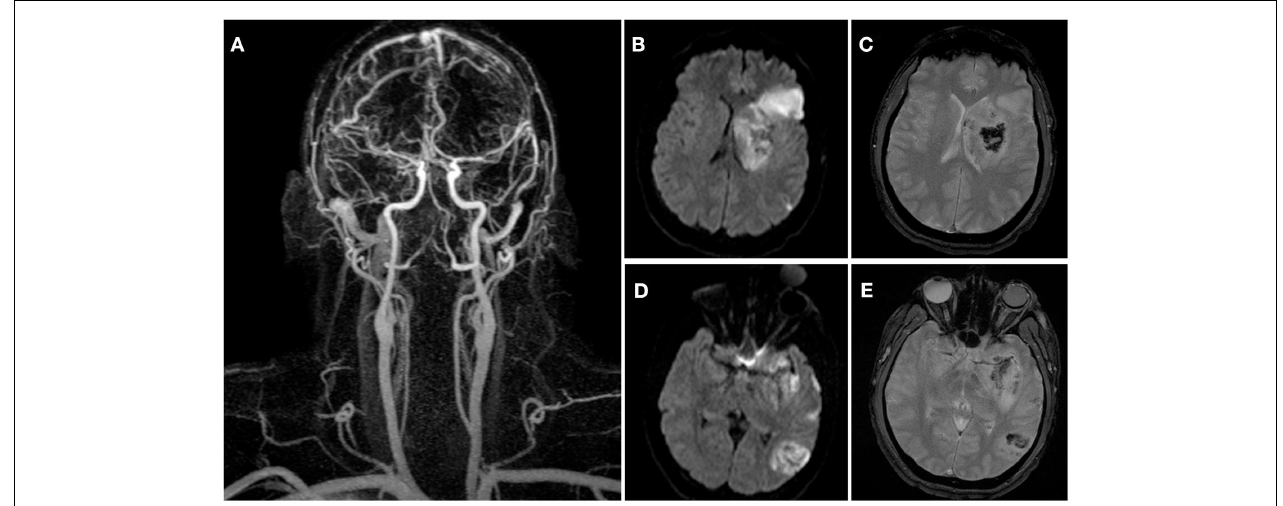
diffusion-weighted (B,D) and gradient echo (C,E) images showing the final infarct volume (41.7 vs. 37.7 cc, initially) and mild hemorrhagic transformation of the lesions.